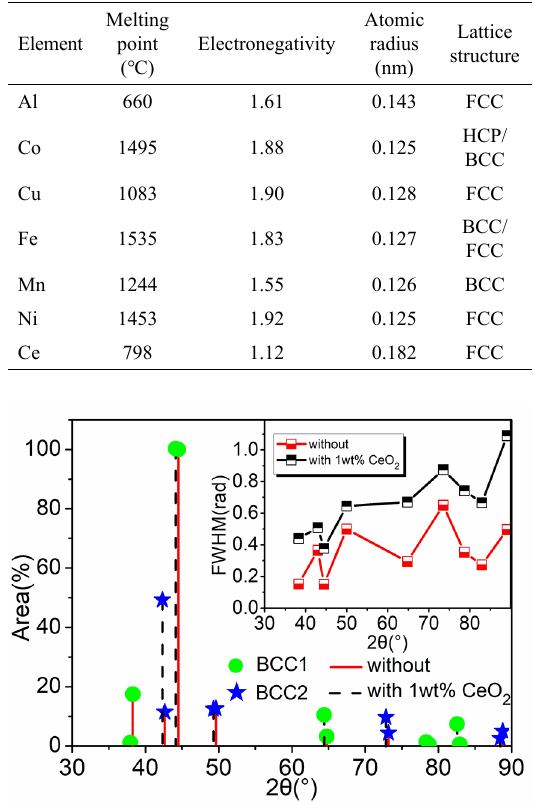
Table 1. Characteristic parameters of HEAC elements